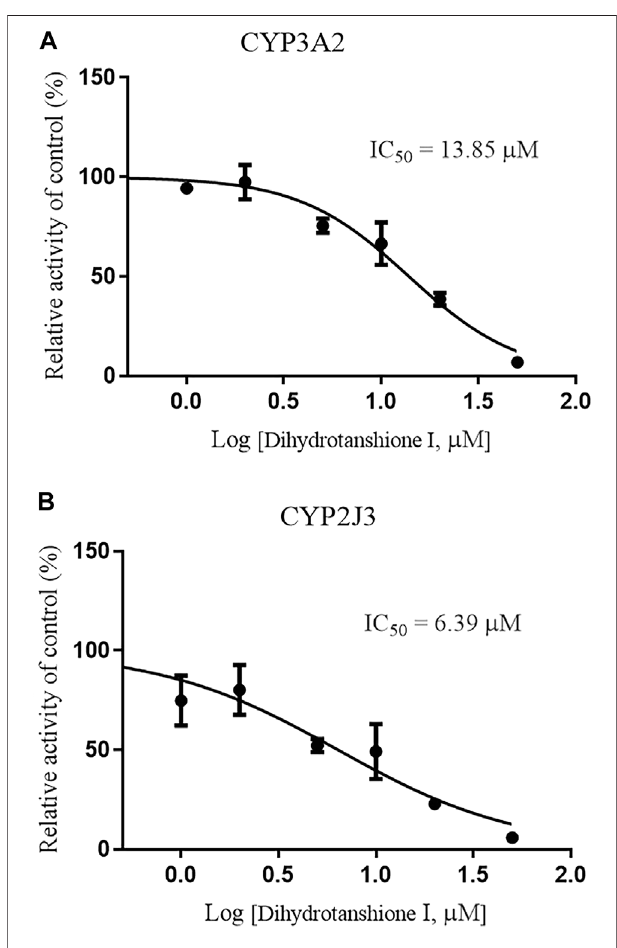
FIGURE 6 | Inhibition of CYP3A2 (A) and CYP2J3 (B) activities by dihydrotanshione I (1 – 50 μ M) in RLM. Values are expressed as mean ± SD of quadruplicate assays. The data were fi t to log (dihydrotanshione I concentration) and normalized response equations using GraphPad Prism